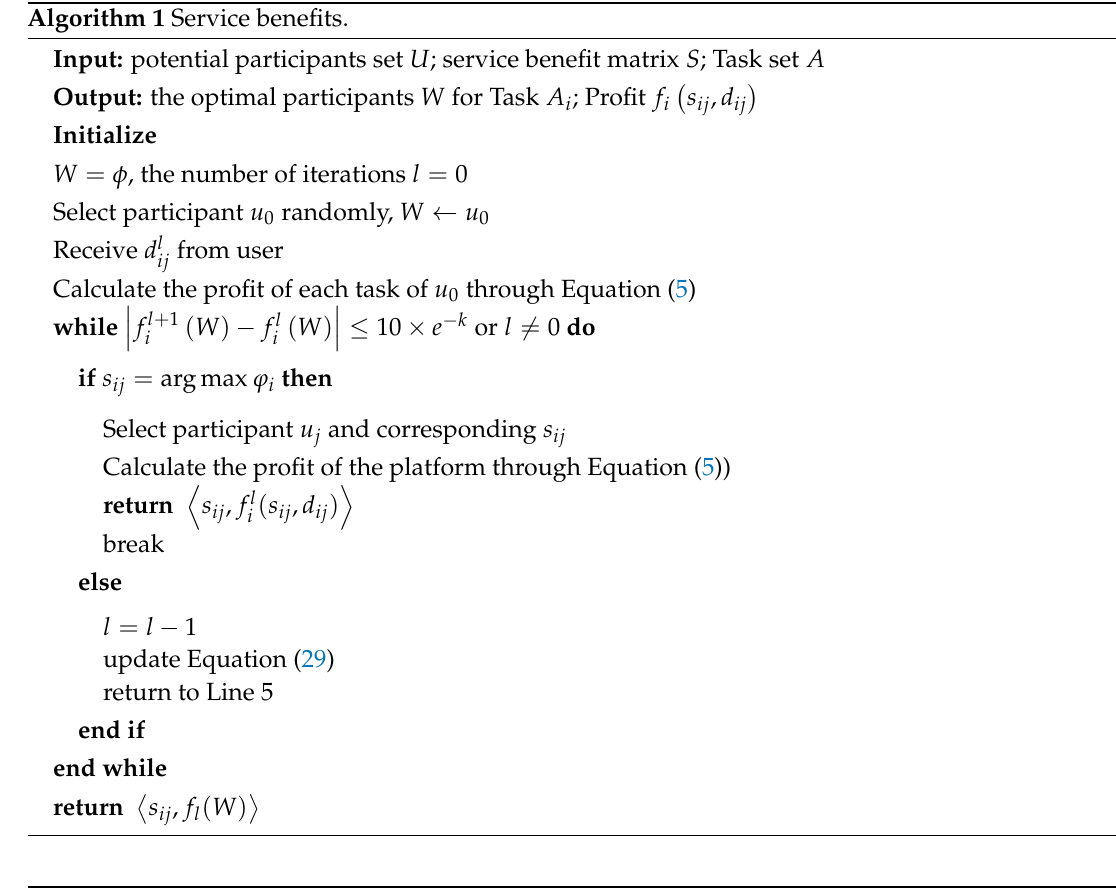
Algorithm 2 Iterative of d ij